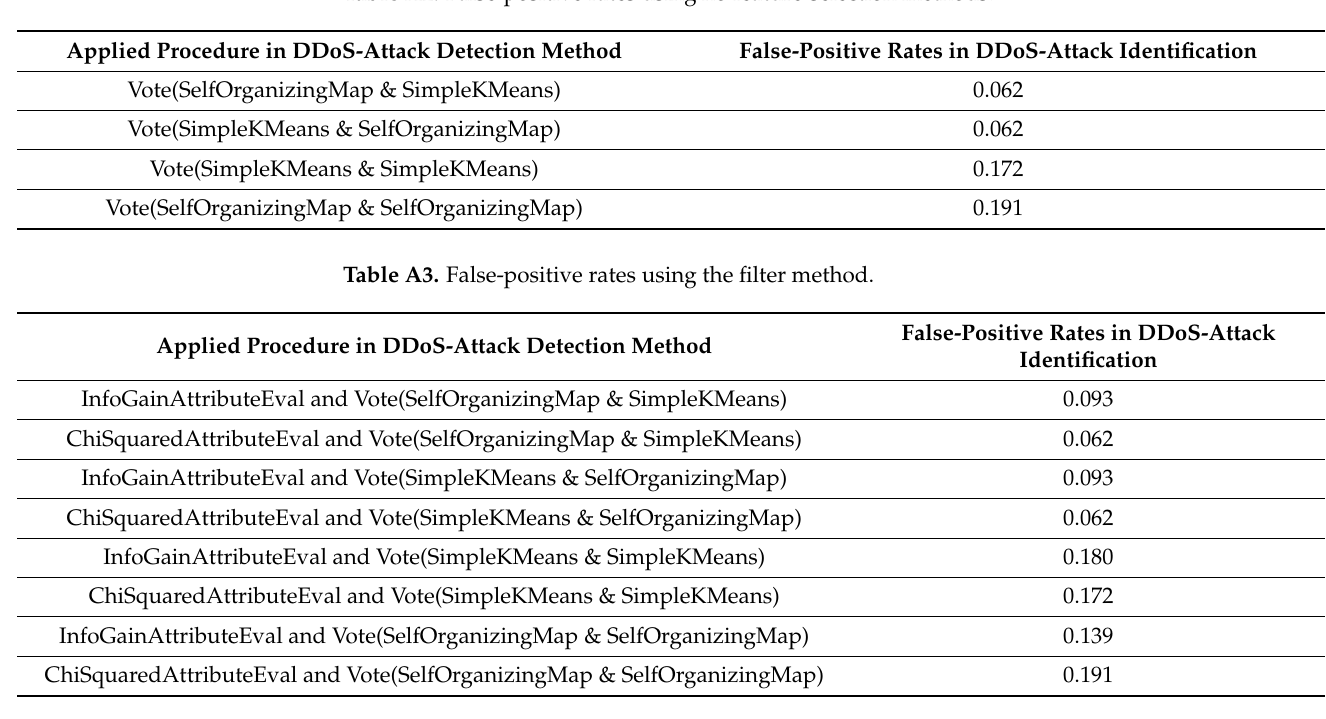
Table A2. False-positive rates using no feature-selection methods.